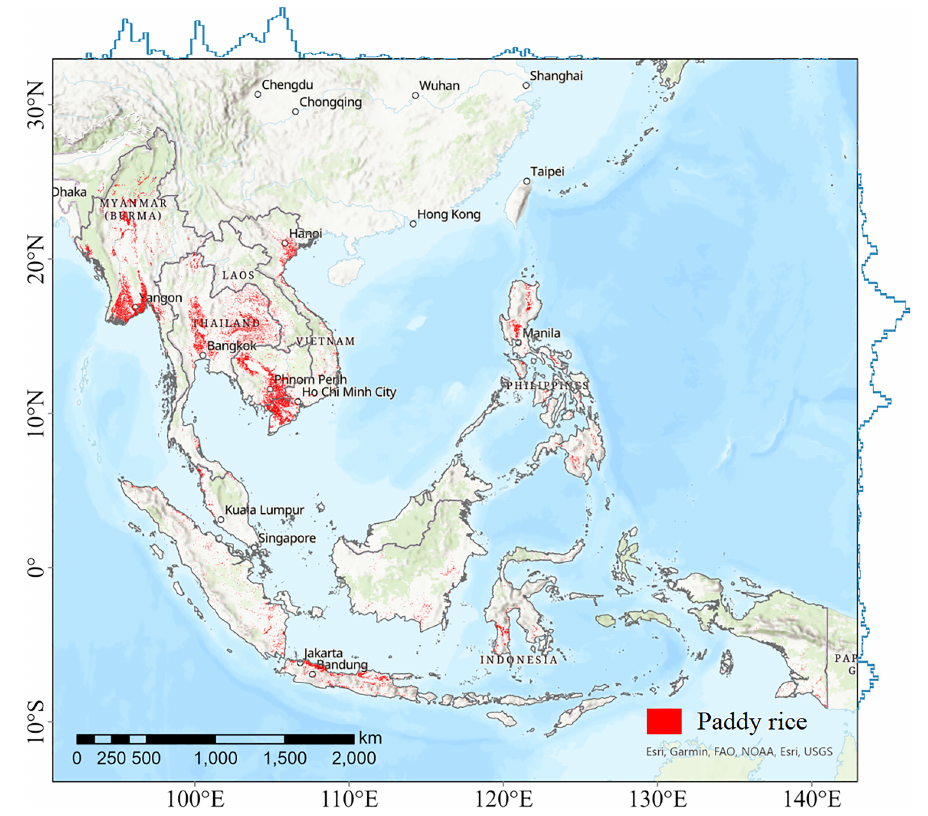
Figure 8. Spatial distribution of classified composite paddy rice with 10m spatial resolution in SE Asia during 2017–2019. The curves represent the relative change rate in the distribution of the number of paddy rice pixels along the longitude and latitude